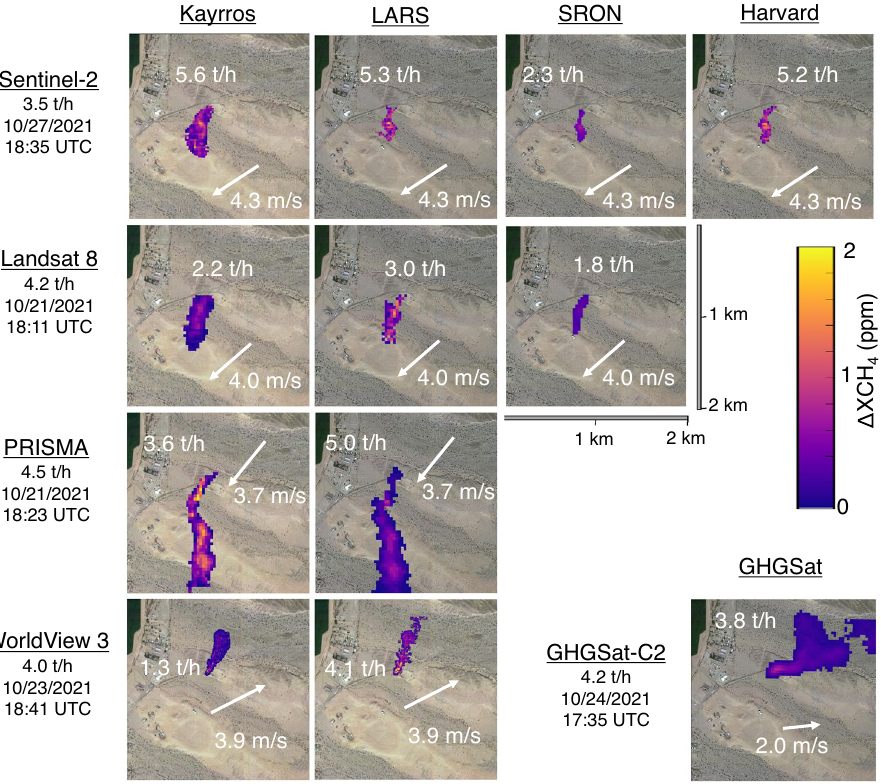
Figure 2. Visualization of detected emissions for all satellite-team combinations for mean metered release values in the 4 t/h approximate range (3.6–4.5 t/h). The true measured emissions rate and timestamp are given below satellite name. Mean estimated volume from each team/satellite pair, as well as measured 1-min average 10 m wind speed and direction, are superimposed on the corresponding picture. Note that measured time trends in wind speed and direction can cause irregular plume shapes, e.g. for PRISMA and GHGSat-C2, which are also cut off in these images due to plume length. See the SI, Section S7 for full plume images. Surface imagery © 2021 Google